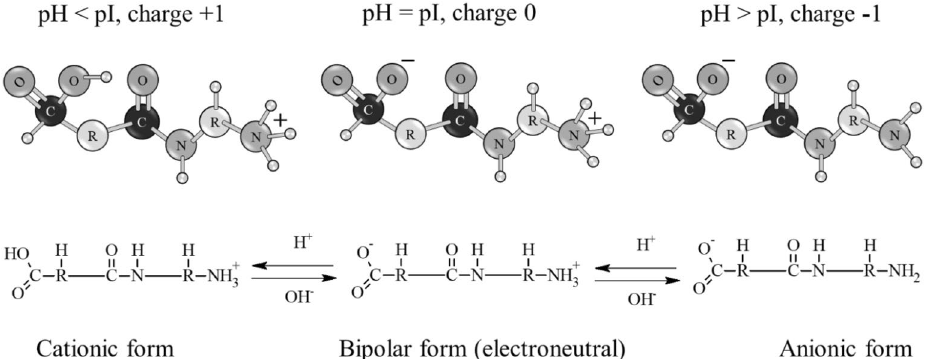
Figure 13. Scheme of protonation and deprotonation of a gelatin